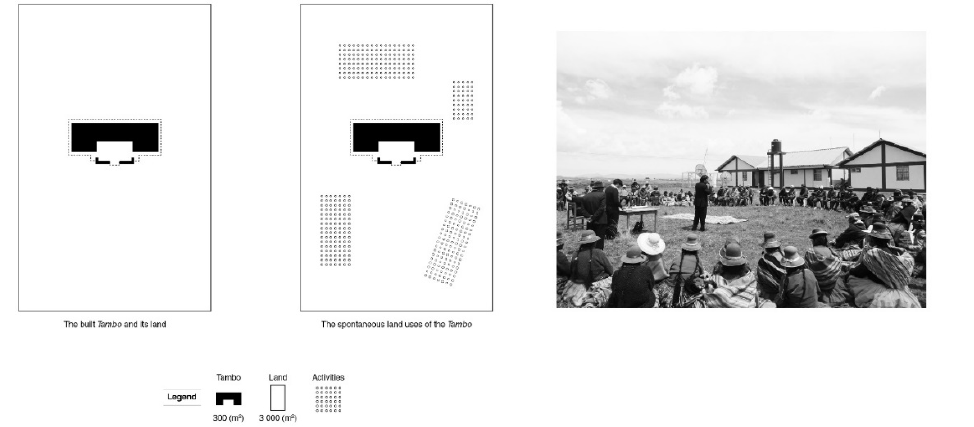
Figure 10. The land use of a typical Tambo for community meeting (source: MIDIS, 2014)